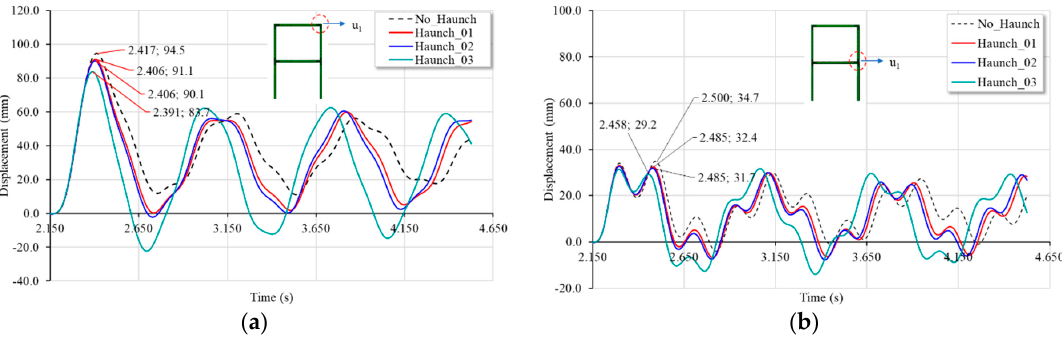
Figure 22. ( a ) Lateral displacement response history at top right corner of the frame; ( b ) Lateral displacement response history at right end of the lower beam.